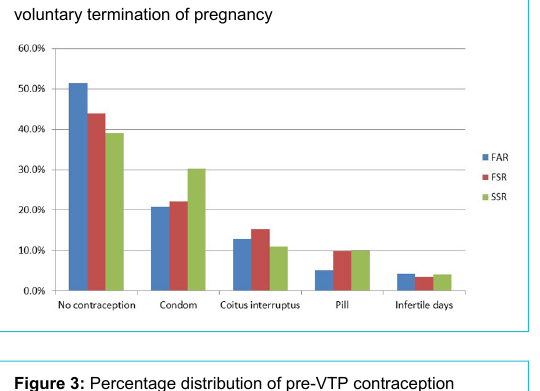
Figure 2: Contraception methods used by women before pre-VTP counselling according to nationality and residence group. FAR = foreign women resident abroad; FSR = foreign women resident in Switzerland; SSR = Swiss women resident in Switzerland; VTP =